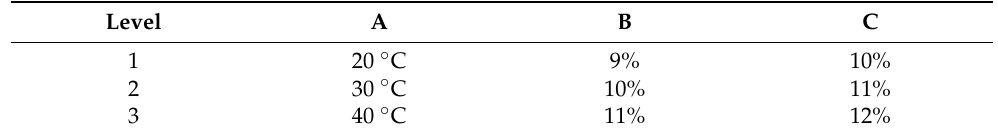
Table 8. Orthogonal test factor selection level